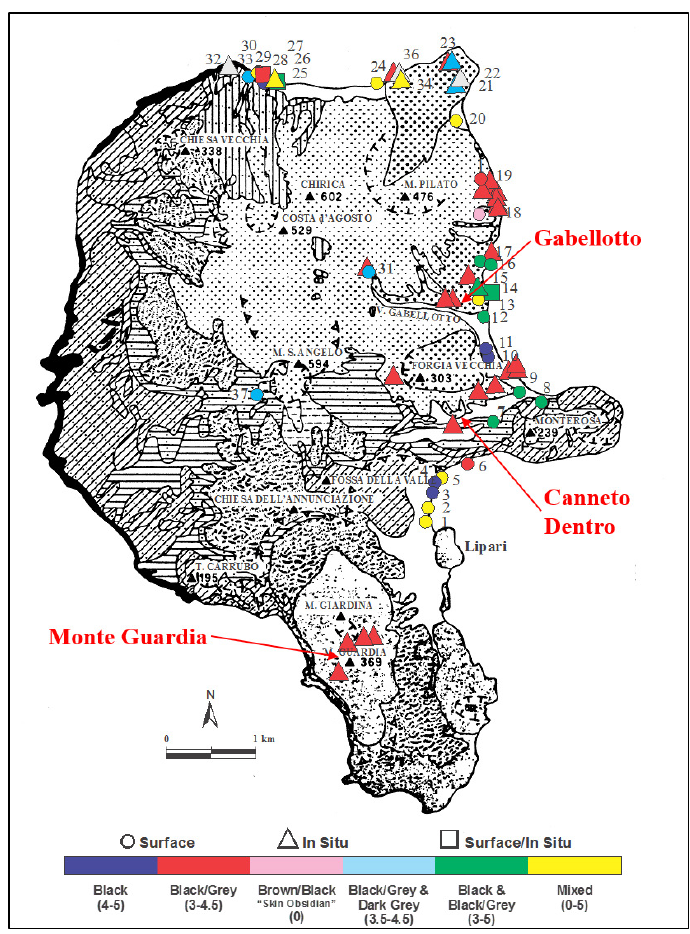
Figure 2. Lipari localities of geological samples collected.